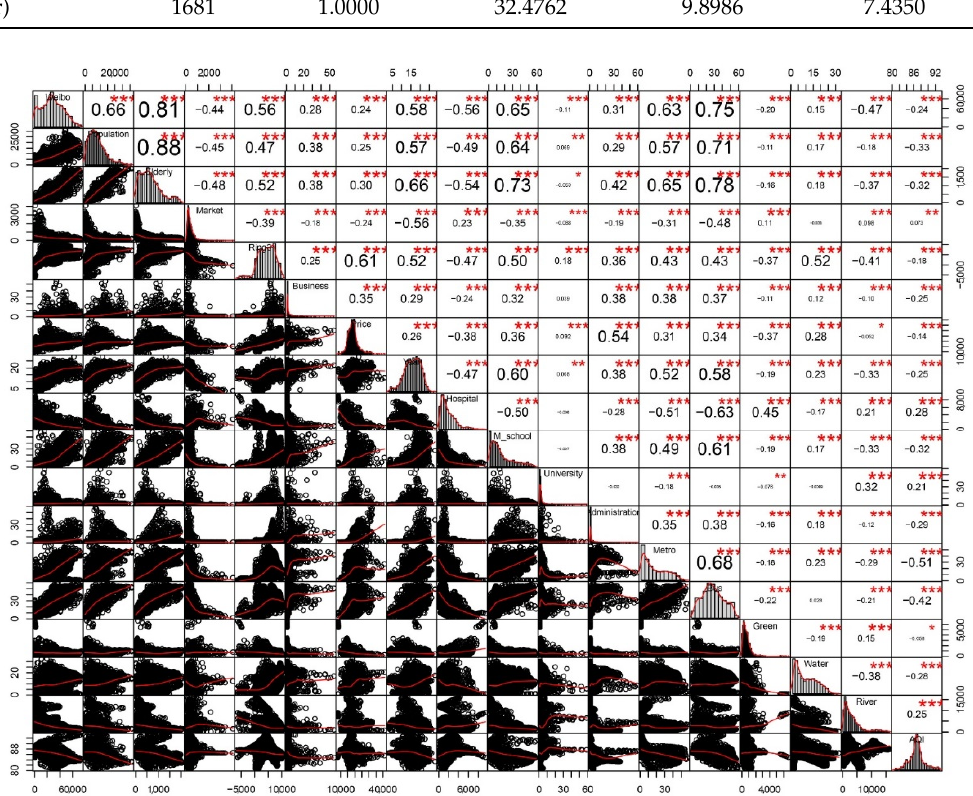
Figure 3. Variable scatter plot. Note: ***, **, * represent significant at the level of 0.001, 0.01, 0.05, respective.